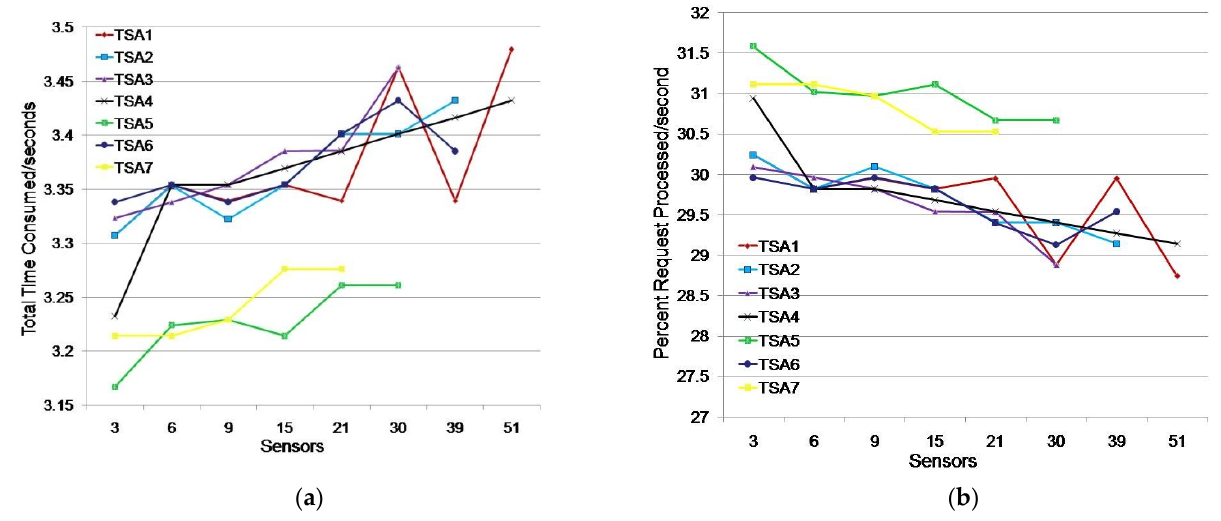
Figure 9. Issuing TSAs timestamps for an environment with three monitoring applications: ( a ) total time consumed (s); ( b ) percentage of requests processed/s. Table 5. Results of TTC and PRP timestamp issuing of TSAs in an environment with three monitoring applications . Sensors Measured Values